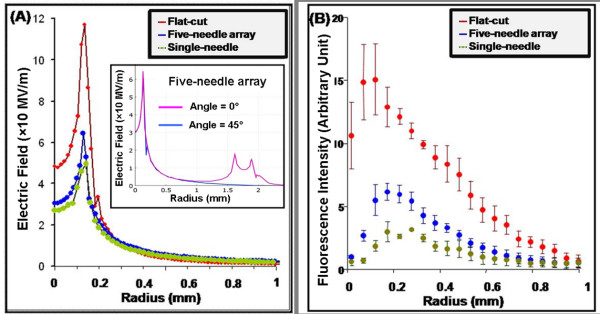
Electric field distributions modeled with the COMSOL Multiphysics electrostatics module (A) and fluorescence intensity distributions of electropermeabilized PC3 cell monolayers (B) for three different electrode configurations.